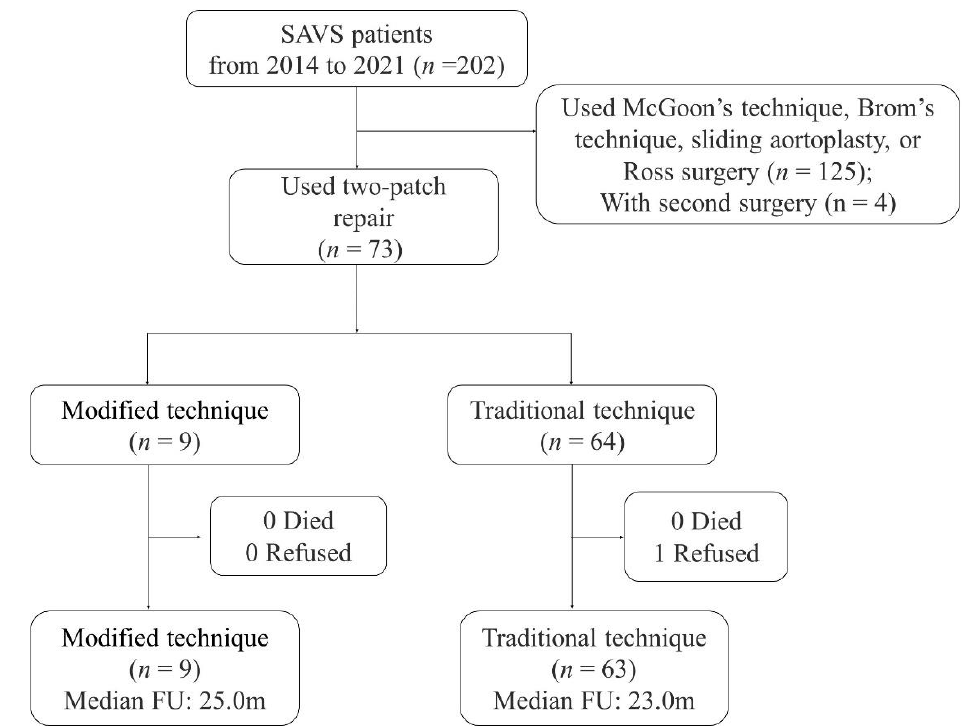
Figure 1. Flow chart of patient selection and follow-up. Abbreviation: FU, follow-up; SVAS, supravalvular aortic stenosis.